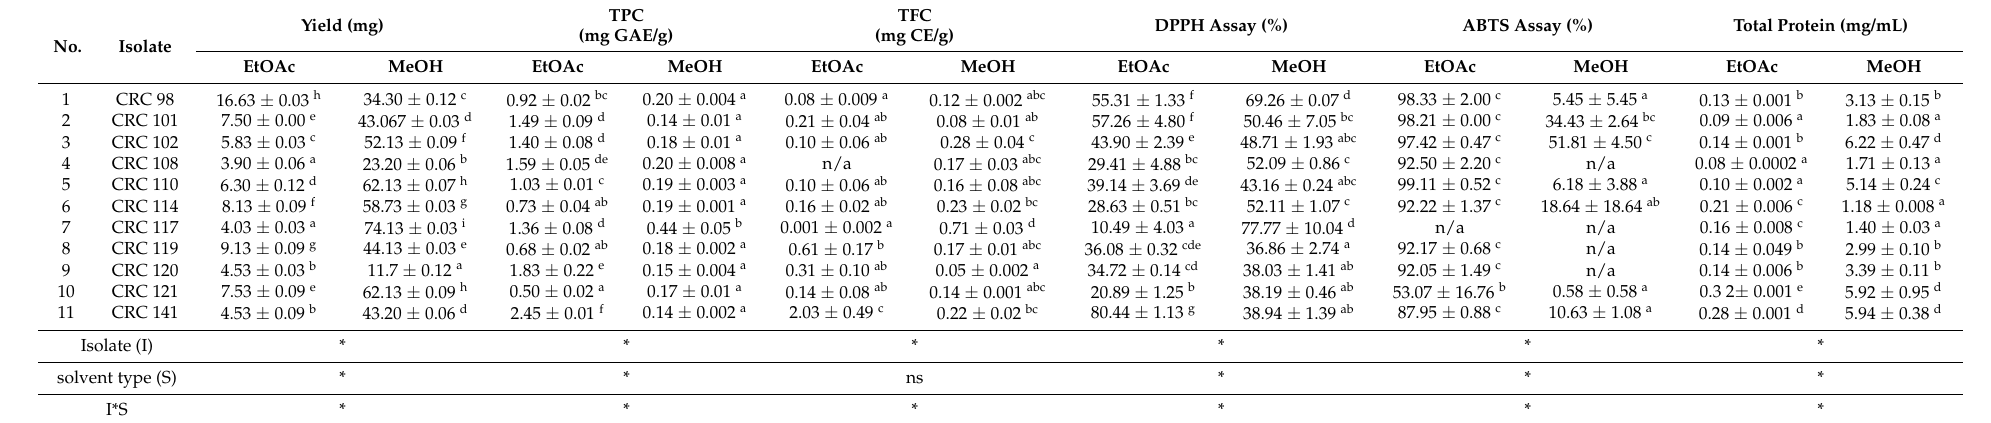
Table 2. Yield, polyphenol compositions, antioxidant activity and protein of the fungal extracts from the filtrate (EtOAc) and mycelium